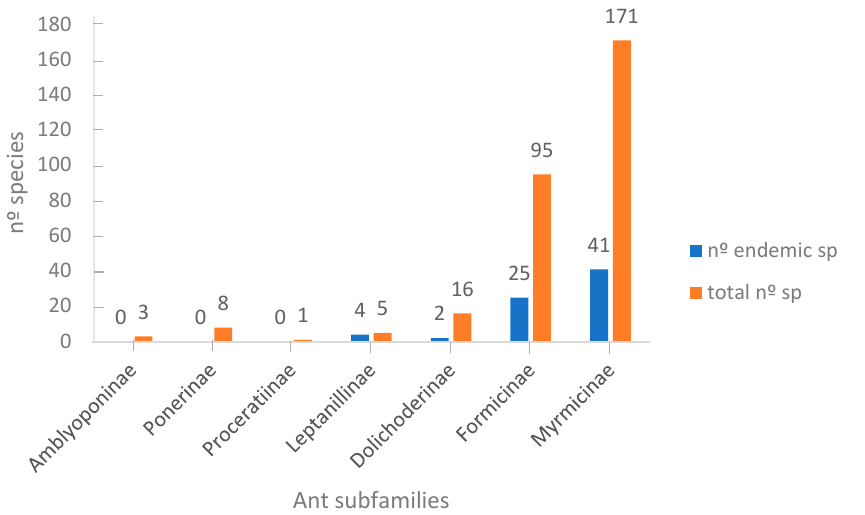
Figure 2. Number of species (orange) and endemic species (blue) belonging to each ant subfamily in the Iberian Peninsula (IP).